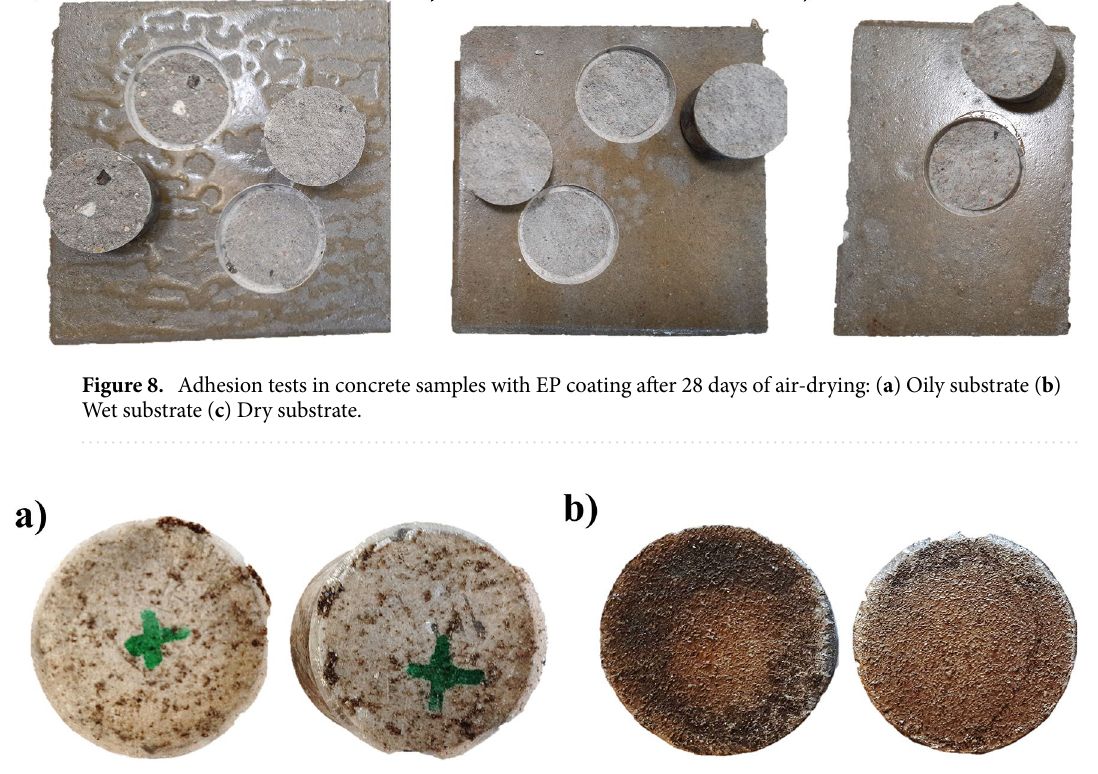
Figure 9. Dolly after pull-off adhesion test in the dry substrate: ( a ) BR samples exposed to air and oven drying ( b ) BR samples exposed to air